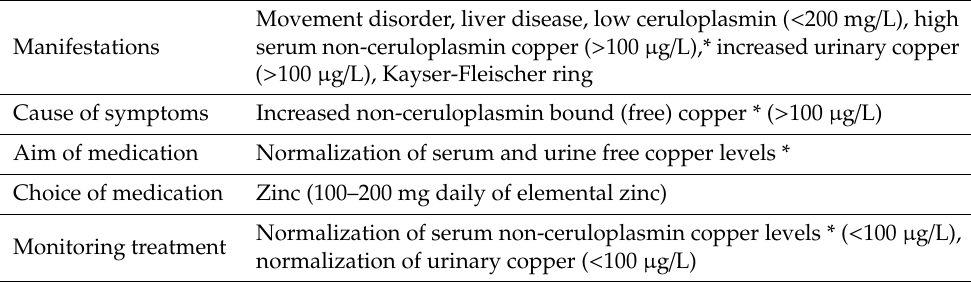
Table 1. Summary of diagnosis and management of patients with copper